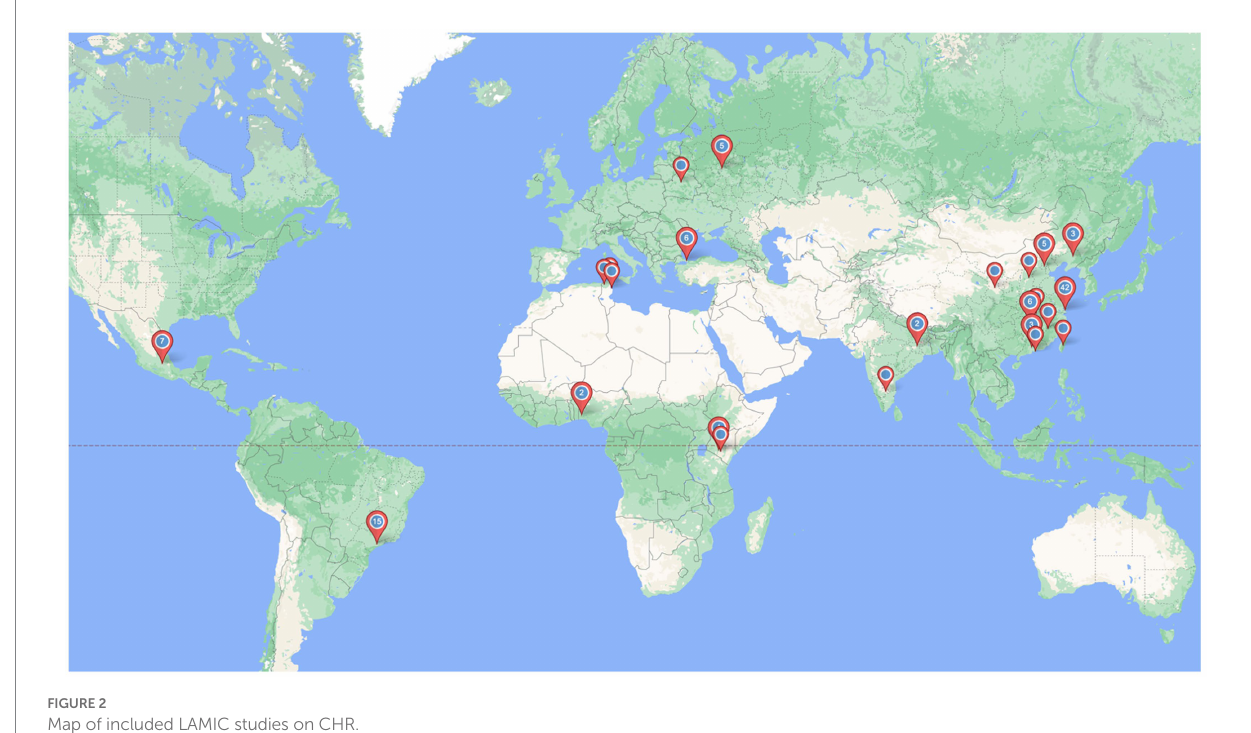
FIGURE 2 Map of included LAMIC studies on